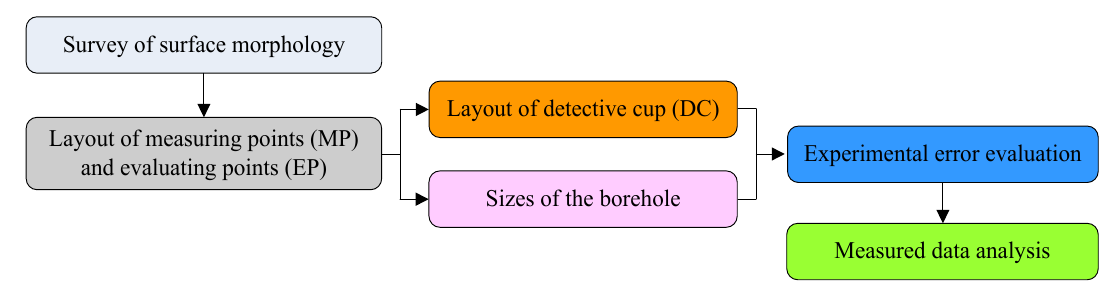
Figure 5. Steps for radon detection on the